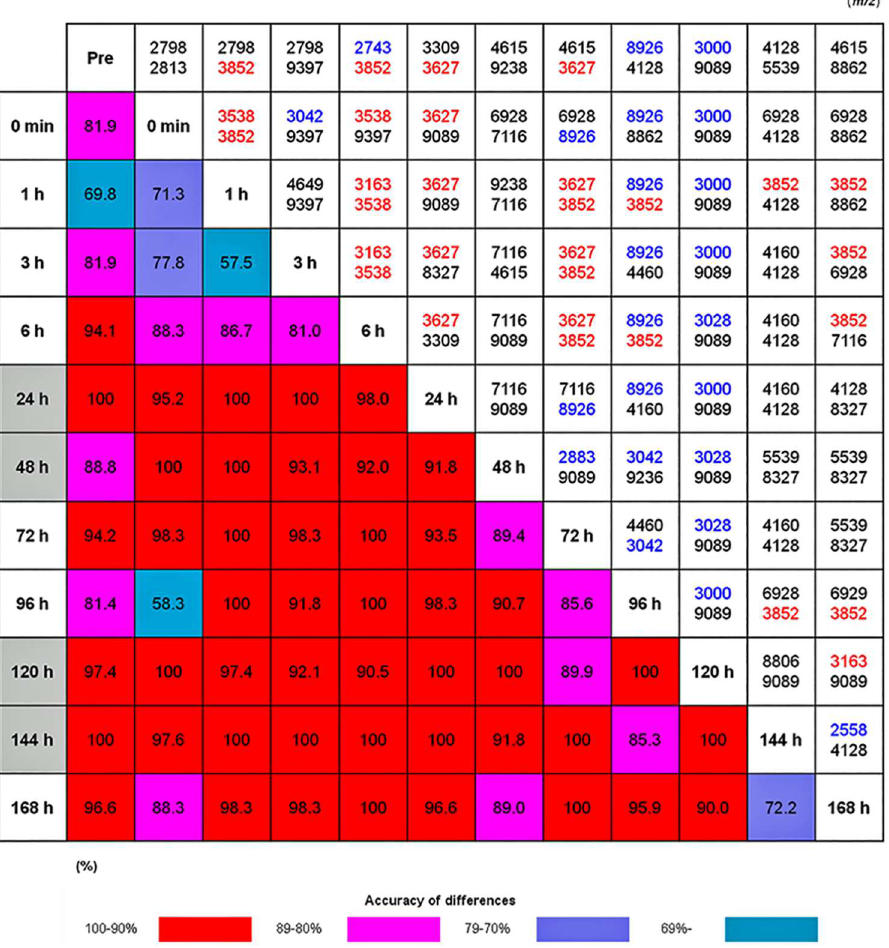
Fig 2. Heat map of the SVM analysis to differentiate each time point after PHx. The lower left half of the figure provides the results of cross-validation analysesto estimate the success rate of the SVM model in separating user-definedgroups of spectra. The accuracy is denotedby color: 100–90%(red); 89–80%(pink); 79–70%(purple), and < 69% (blue). The upper right half of the figure describesthe m/z of the top 2 peaks that most efficiently discriminated each time point with statistical significance. The detailed data used for the analysiswere providedas pseudogel and stack view of the spectra in S1 Fig, and the statistical data were as S2 Table. The identifiedalbuminpeaks are shown in blue (2558: 25–45 * 1 ; 2743: 26–48; 2883: 25–48 * 2 ;